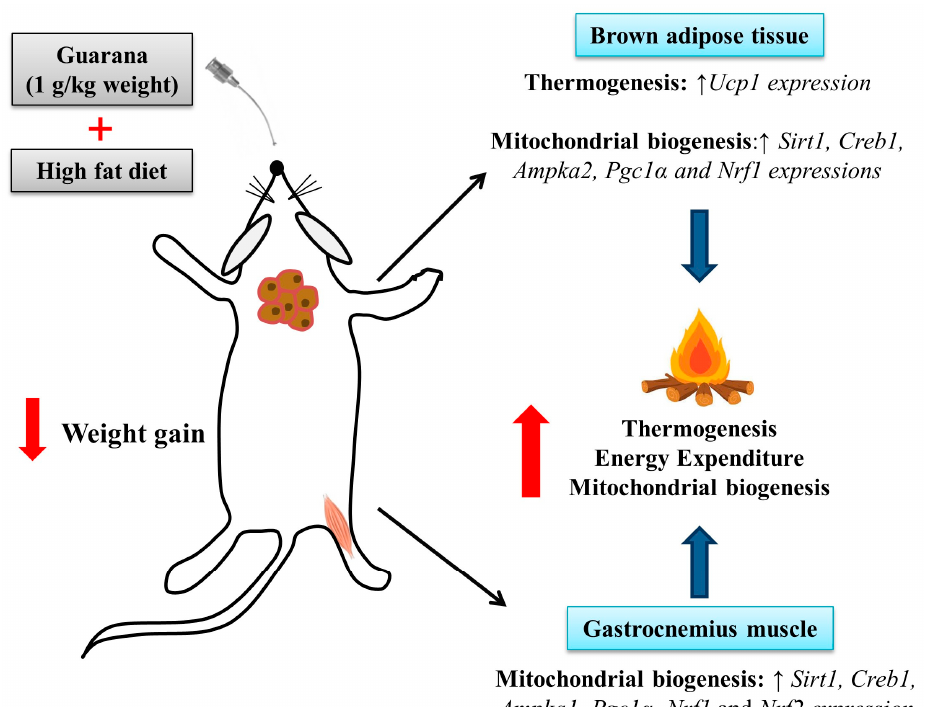
Figure 5. Effects of guarana treatment on mitochondrial biogenesis in gastrocnemius muscle and brown adipose tissue.